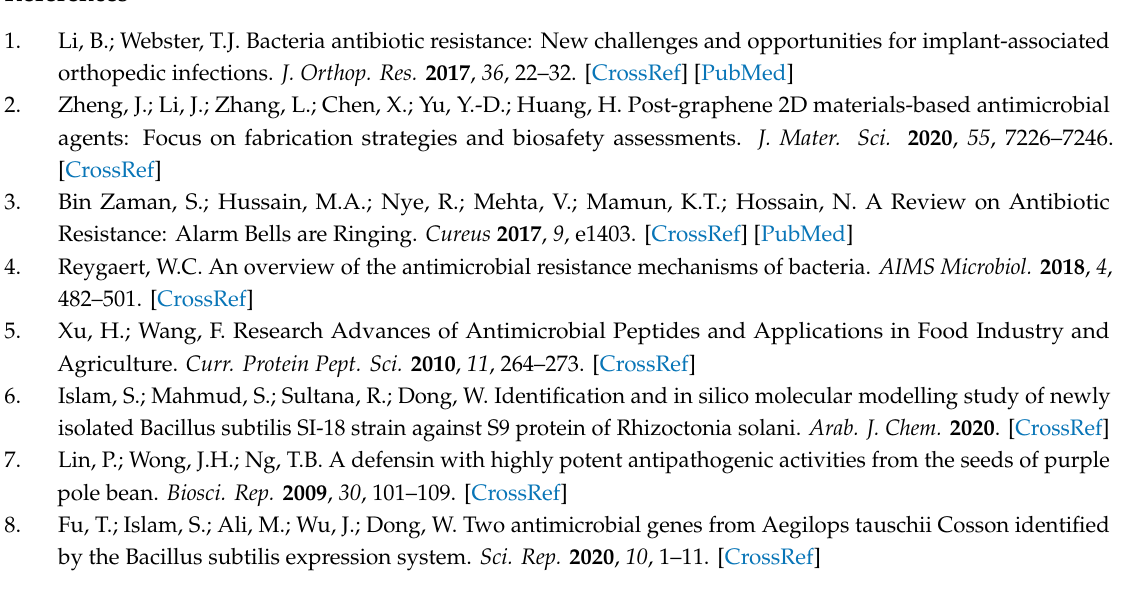
rate of F. graminearum spore, Figure S3. The antimicrobial peptide inhibitory activity on the M. oryzae spore, Figure S4. Detection of fusion peptides via SDS-PAGE, Figure S5. Analysis of Time-Kill curve, Figure S6. Antimicrobial peptides OrR214 and OrR935 caused the reactive oxygen species production in X. oryzae pv. oryzae cells, Table S1. Sequences for His-Tag Fusion Peptide, Table S2. Primers and sequences for building the O. rufipogon library and purifying the proteins, Table S3. The bacteriostatic spectrum of the antimicrobial genes of O. rufipogon , Table S4. Bioinformatics prediction of antibacterial peptide, Method S1: His-tag fusion peptide purification. Author Contributions: J.L. and W.D. conceived and designed the experiments. J.L. and P.G. performed the experiments. J.L., S.I., and W.D. analyzed the data. J.L., S.I. and X.H. contributed to formal analysis. J.L., S.I., and W.D. wrote the manuscript with input from all co-authors. All authors have read and agreed to the